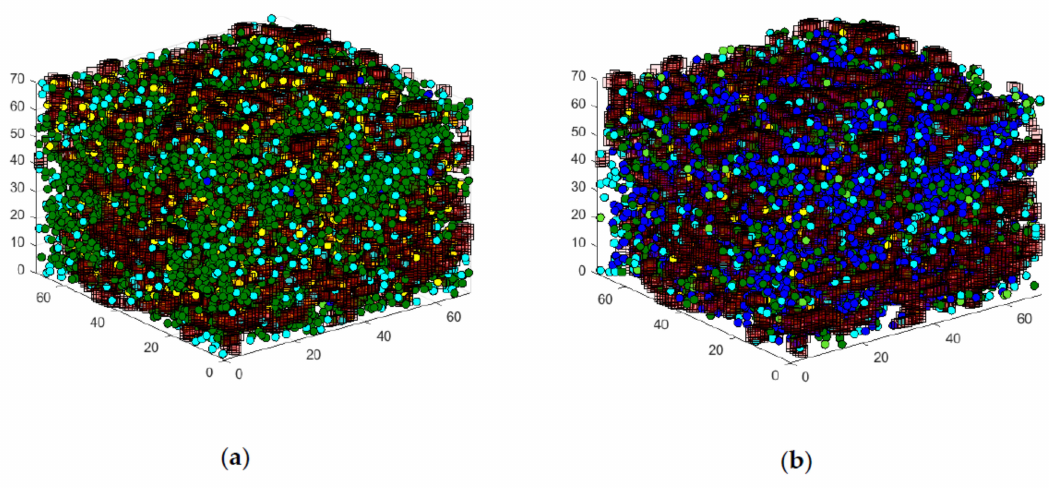
Figure 15. Graphical Cellular Automaton output of a configuration of the model, ( a ) without stimulation, ( b ) with glucose